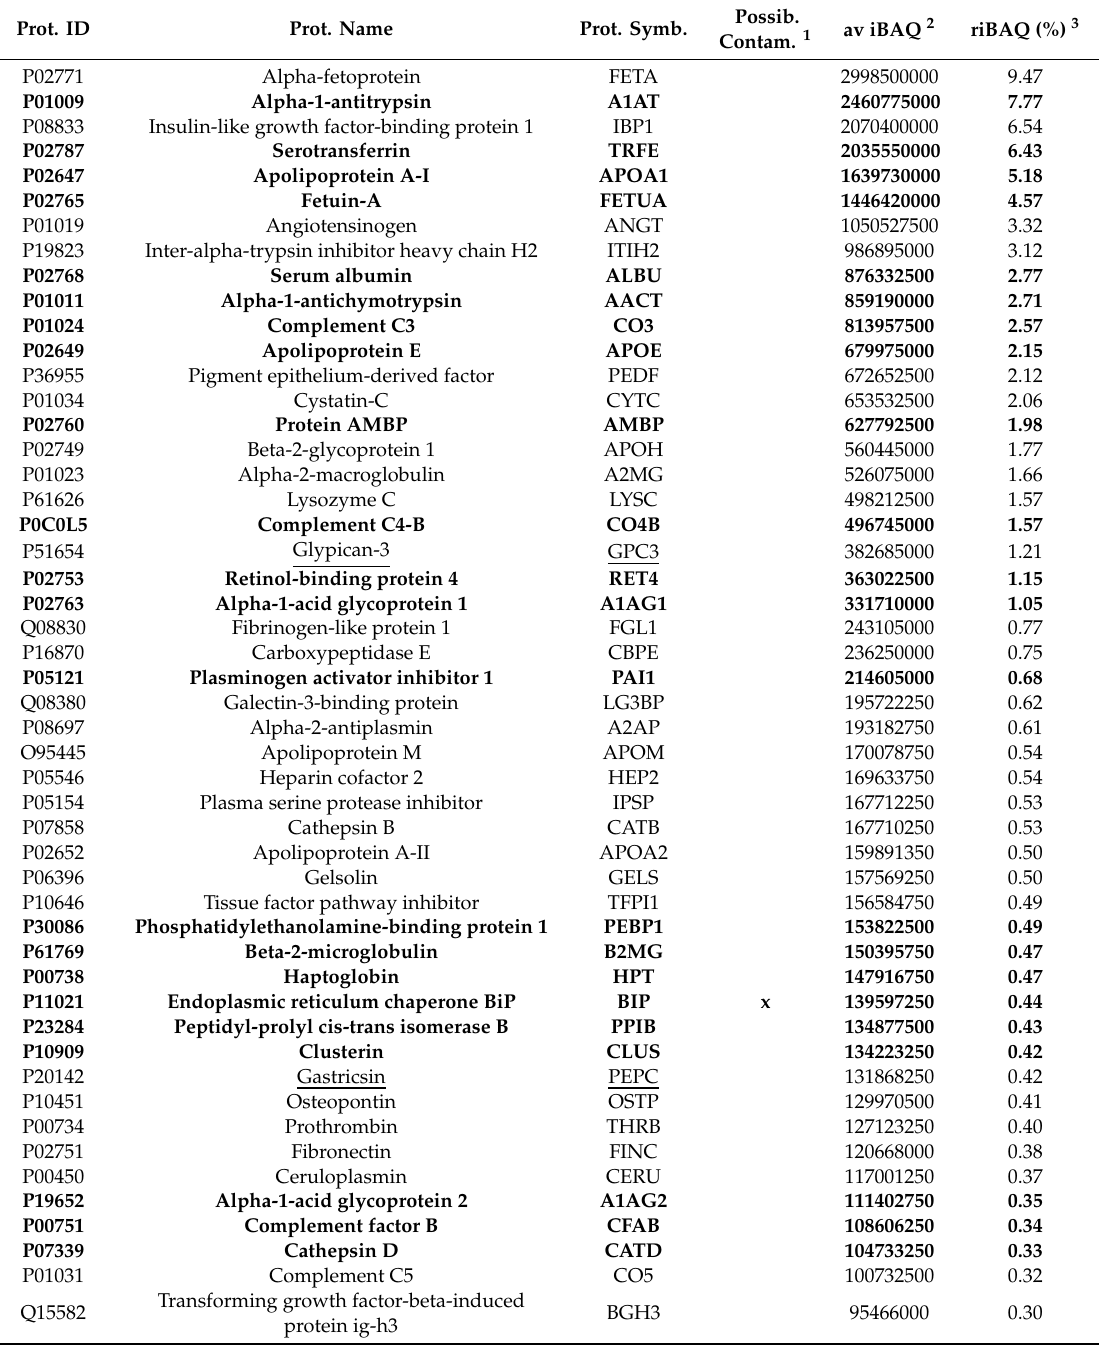
Table 3. HepG2 riBAQ list—top 50